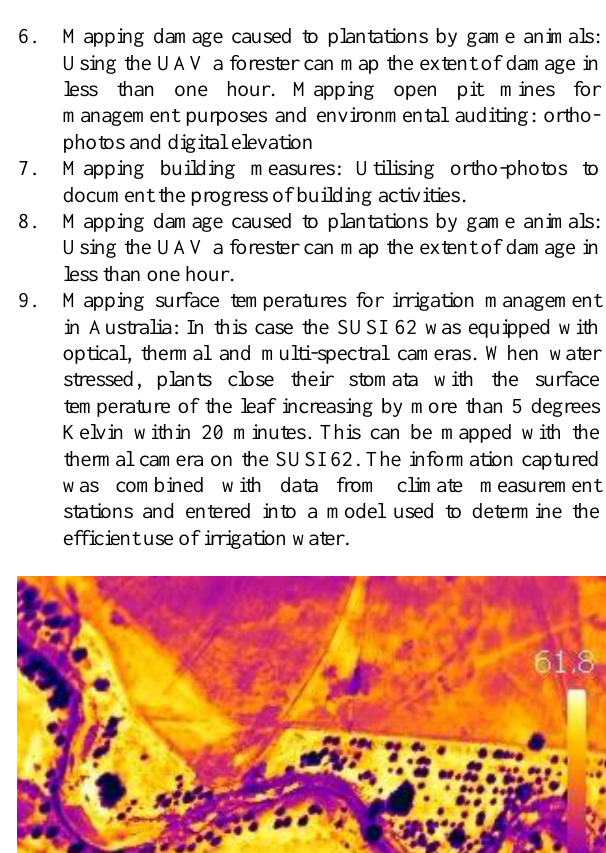
Figure 8. Profile of the open pit mine.